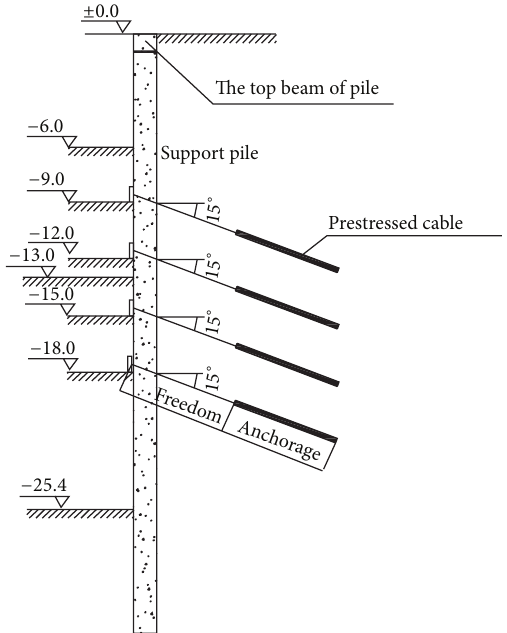
Figure 13: Sectional view of foundation support structure.